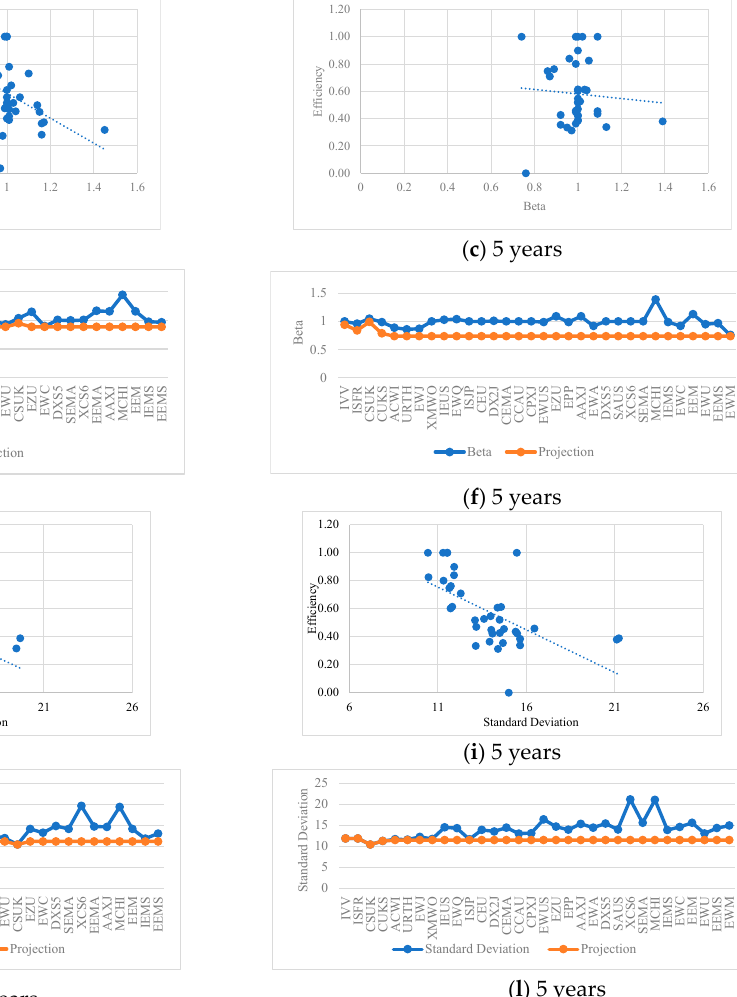
Figure 3. Efficiency scores vs. inputs and projections (ETFs are ordered in decreasing order of efficiency) for the different time